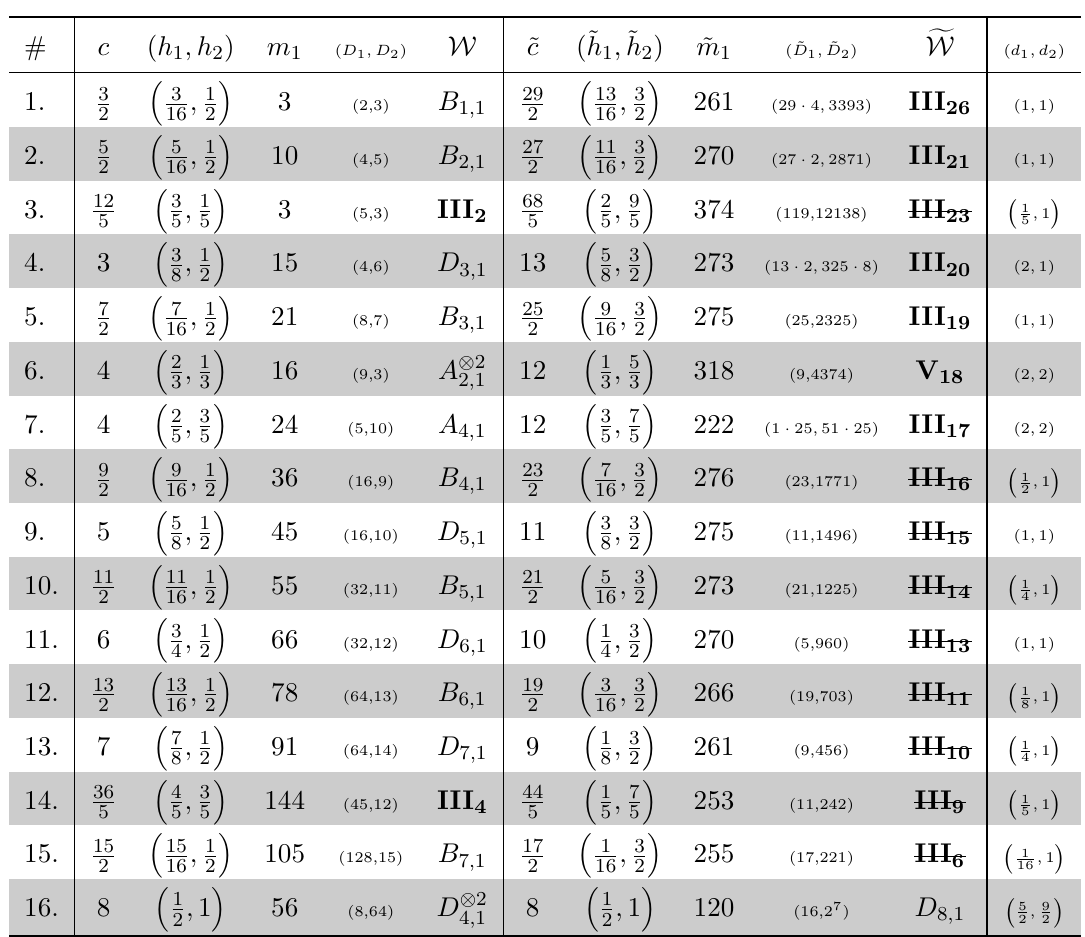
Table 7. Inconsistent pairings, c H = 16 with ( n 1 , n 2 ) = (1 , 2) . The two sets of characters pair up to j 2 3